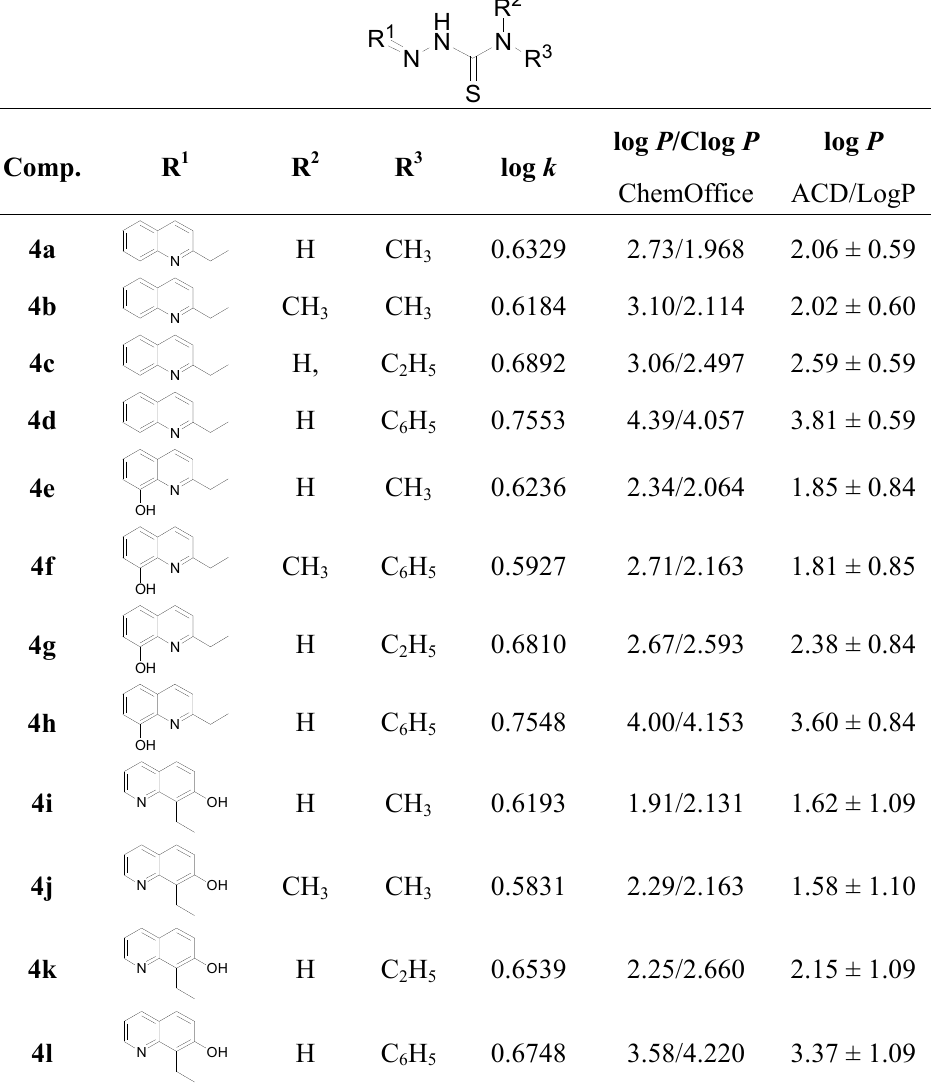
R 2 H R 1 N N N R 3 S log P /Clog P log